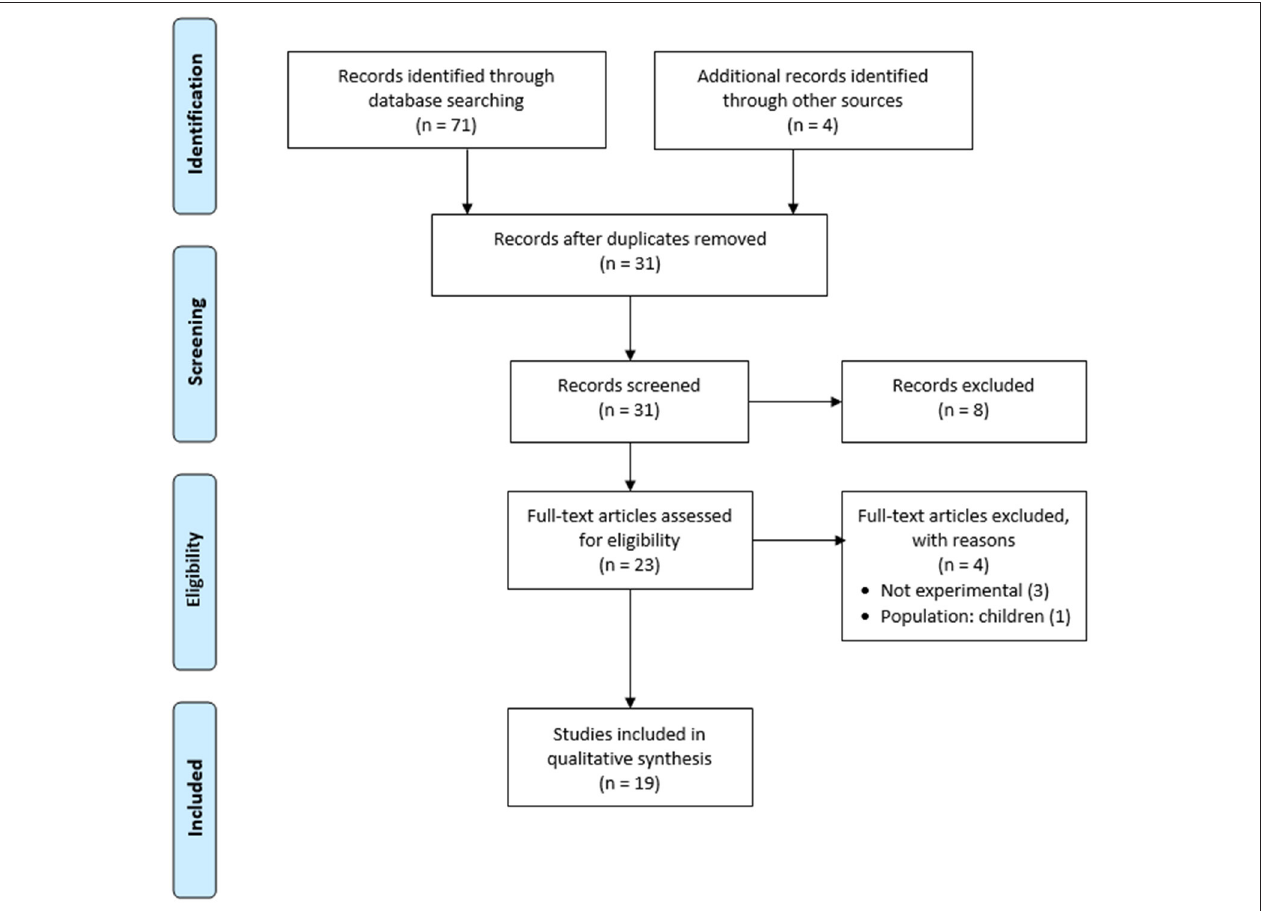
FIGURE 1 | Flow chart of data selection for the